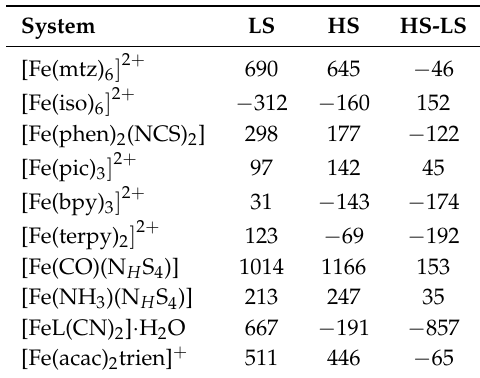
Figure 4. ( Left ) Off-center Fe displacement vibrational mode of the LS state of [Fe(NCS) 2 (NCH) 4 ]. ( Right ) Comparison of the harmonic potential energy curve (in green) and the calculated energies (blue dots) fitted with a quartic expression (red line). Table 1. Contribution of the anharmonicity to the zero point energy with respect to the harmonic value (in cm − 1 ). HS,